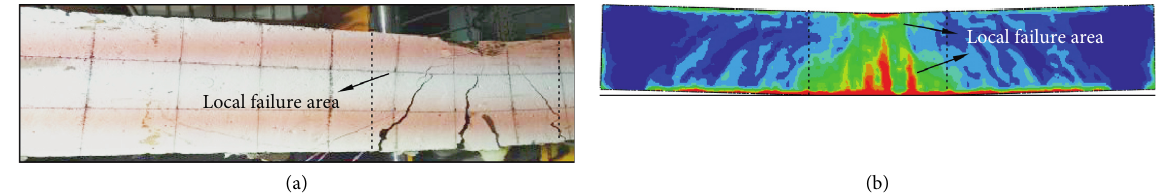
Figure 10: Beam L16-1.